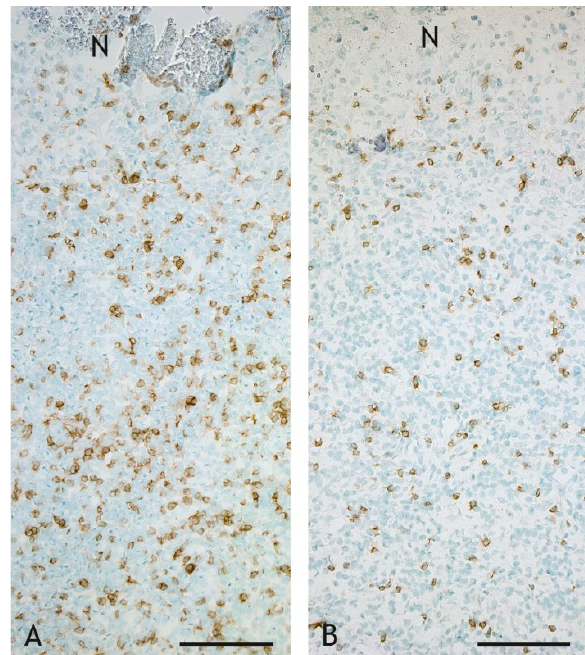
Figure 13. CD4 + T cells in the inflammatory infiltrate of granulomas. The number of CD4 + T cells is higher in the BCG-induced granuloma (( A ), goat 13) compared to the VPM1002-induced granuloma (( B ), goat 24). IHC, CD4. Scale bars = 100 µm.